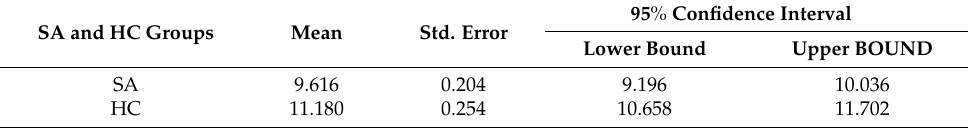
Table 3. Estimates for Groups.